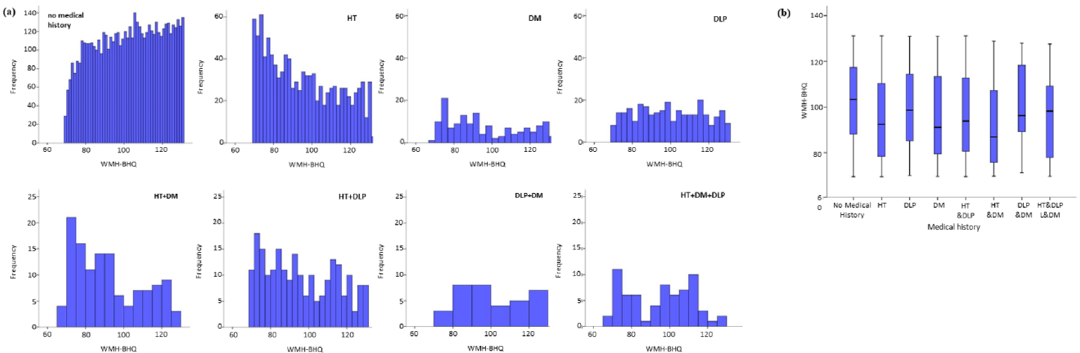
Figure 5. Histograms ( a ) and box plots ( b ) of WMH-BHQ according to no medical history, single morbidity, and multiple comorbidities. HT: Hypertension, DM: Diabetes mellitus, DLP: Dyslipidemia. Table 5. Dunn test of WMH-BHQ among no medical history, hypertenstion (HT), diabetes mellitus (DM), dyslipidemia (DLP), and the comorbidities. Pairwise Comparison by Dunn Test Comparison 1